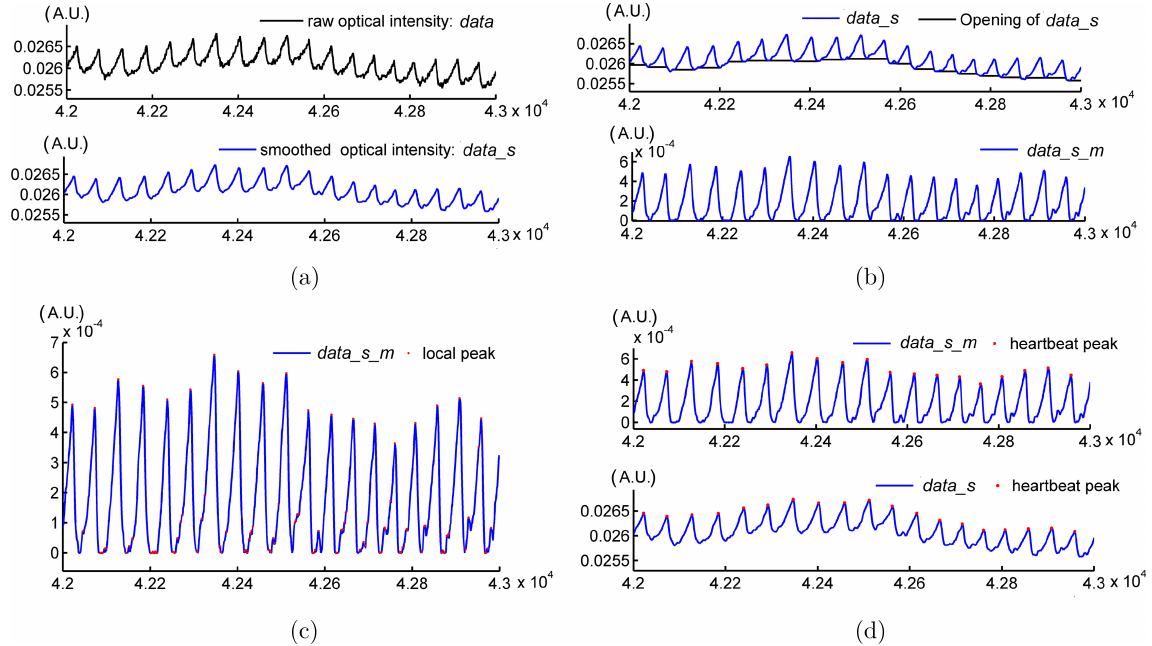
Fig. 3. Illustration of our method. (a) The raw optical intensity (data) and the smoothed optical intensity (data s ) after step (1). (b) data s and its opening (top), and the residual signal data s m after step (2). (c) All local peaks are found in data s m after step (3) and marked with red dots. (d) All heartbeat peaks are identi¯ed in data s m after step (4) and marked with red dots in data s m (top) and in data s (bottom). Figure 3 shows the results over a typical period of time from one channel of one subject. The horizontal axis represents time in